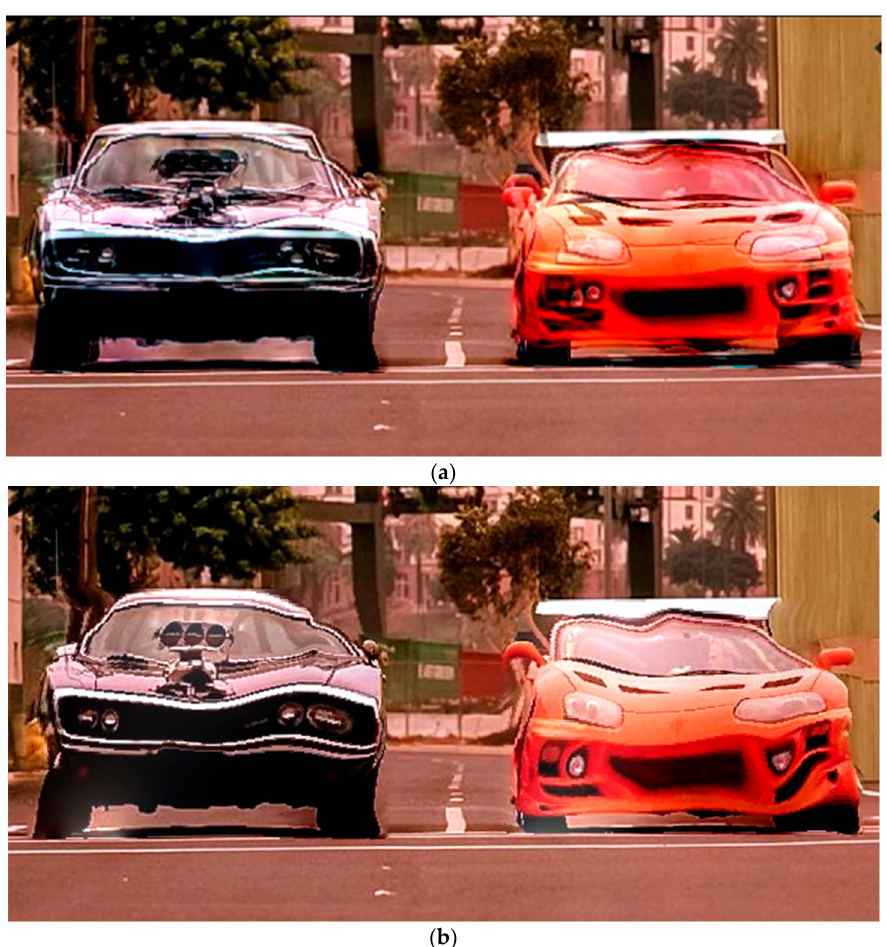
Figure 10. Outputs of different blending techniques: ( a ) Alpha blending; ( b ) Poisson blending.